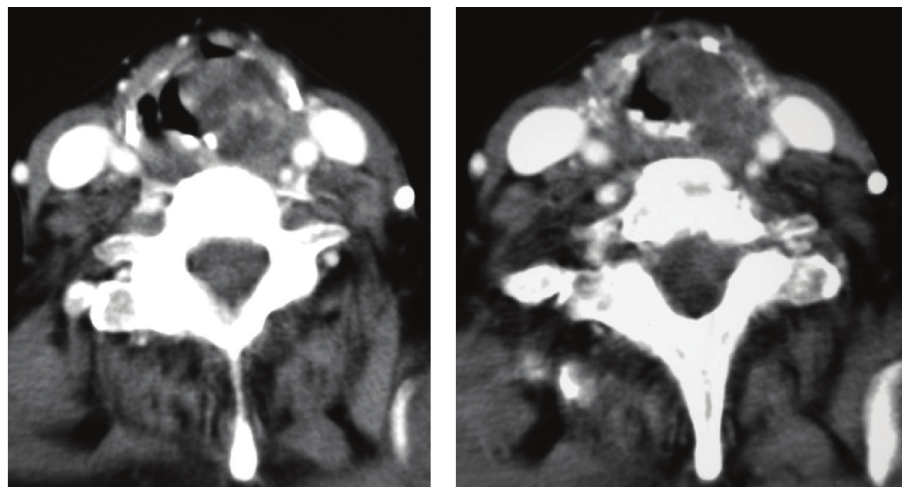
Figure 1: Axial CT scan showed an expansive mass occupying glottic space, originating from the left aryepiglottic fold.